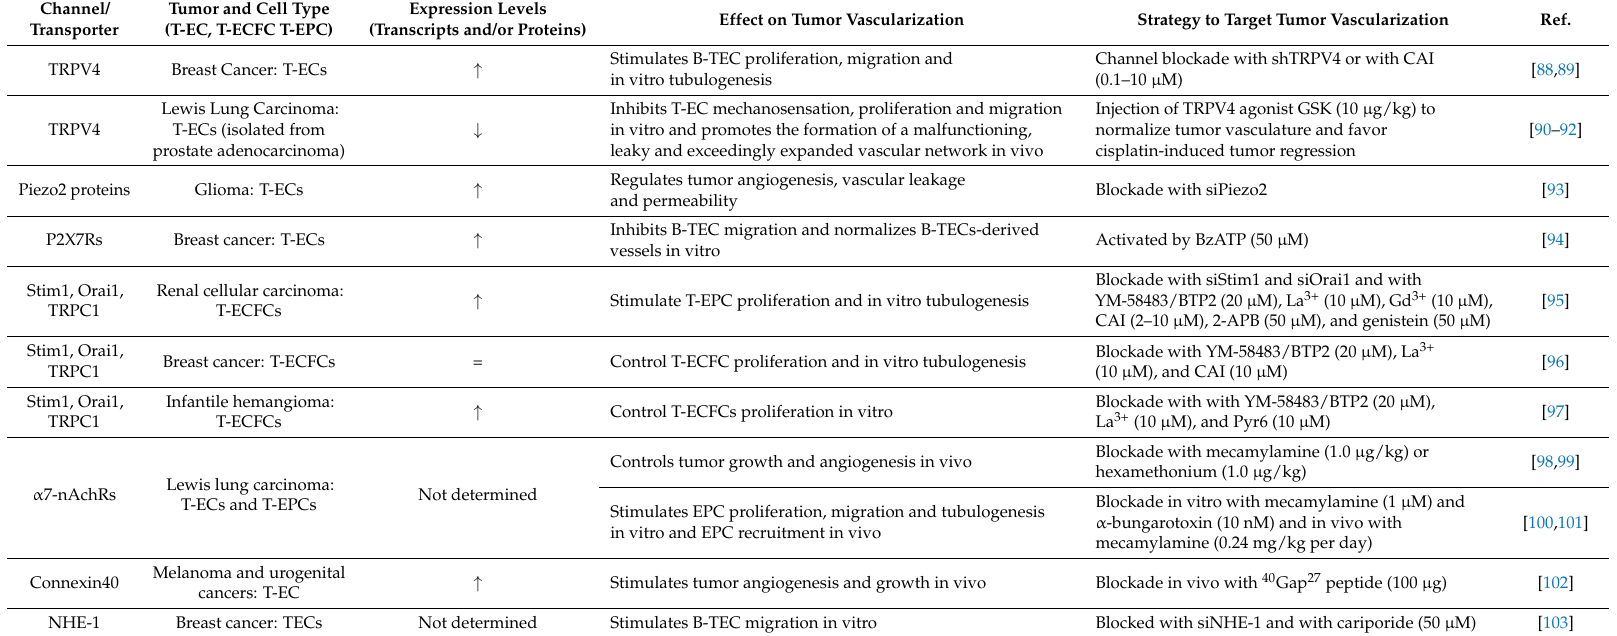
Table 1. Channels and transporters directly supporting tumor vascularization.